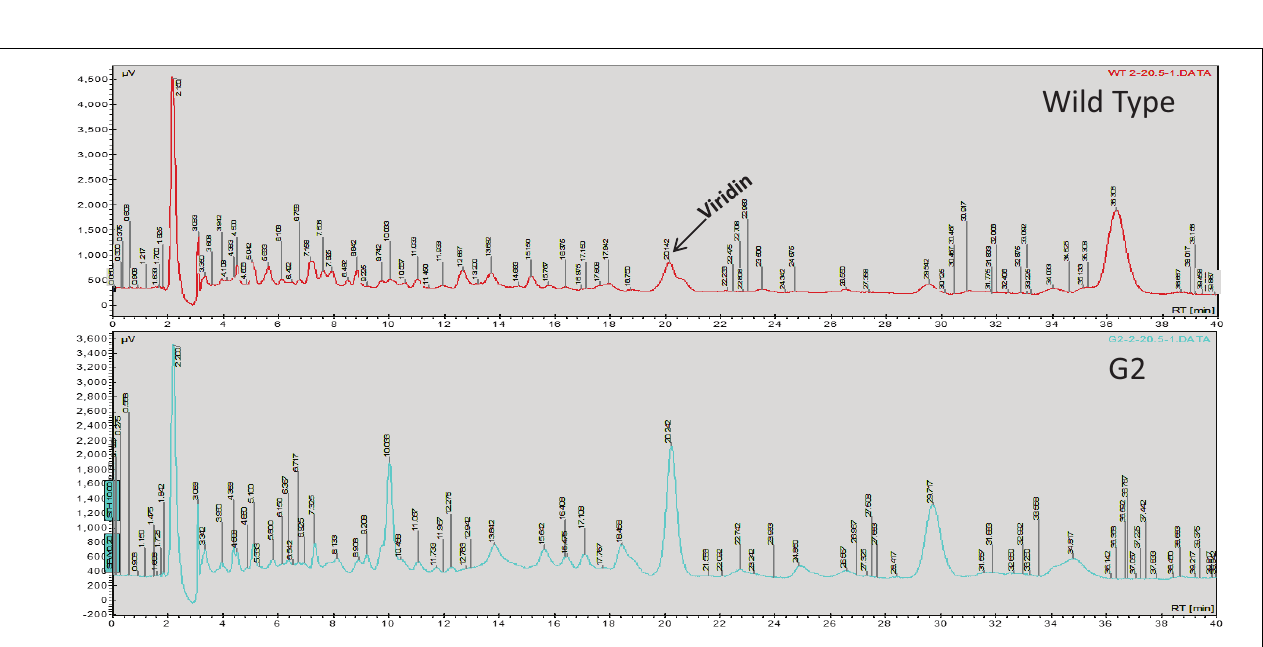
FIGURE 5 | HPLC analysis of culture filtrate of WT and